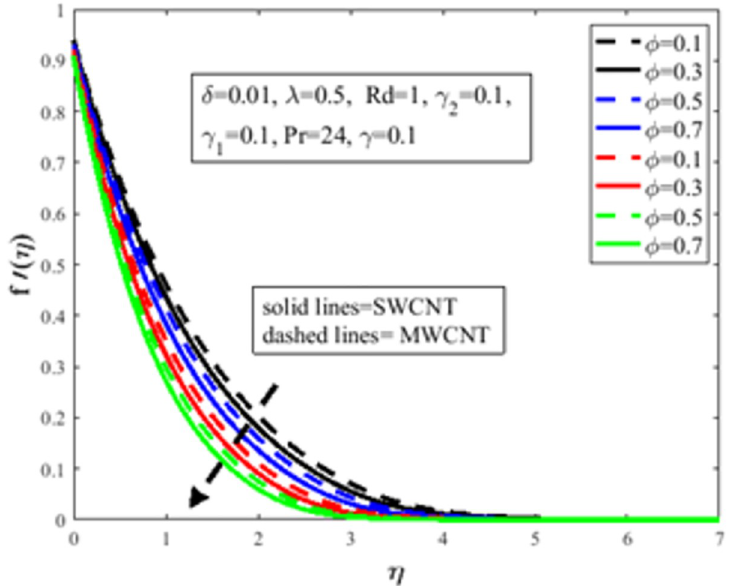
Fig 9. Effect of ϕ on g ( η ).